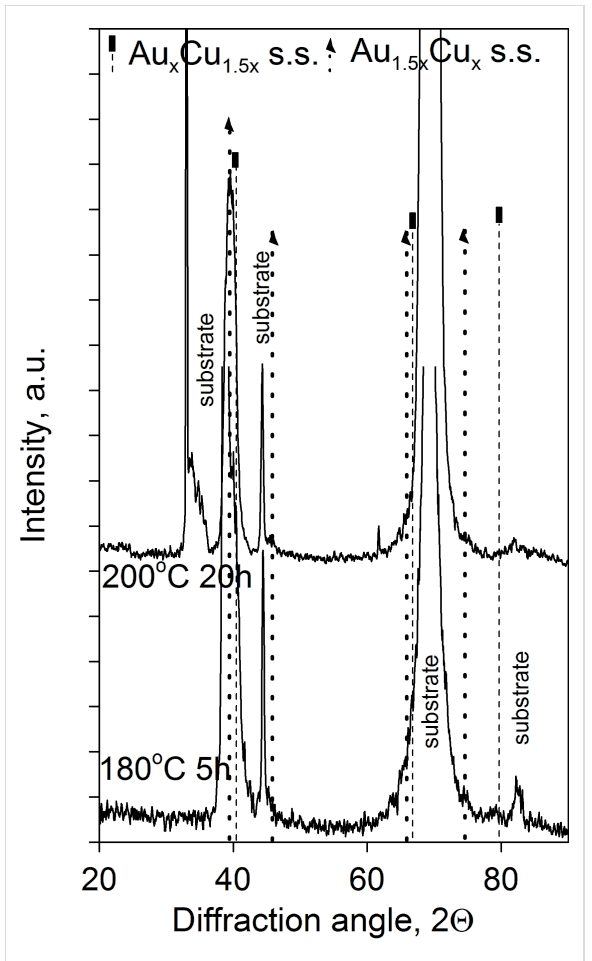
Figure 8: XRD θ –2 θ patterns of Au(25nm)/Cu(12nm) annealed samples.